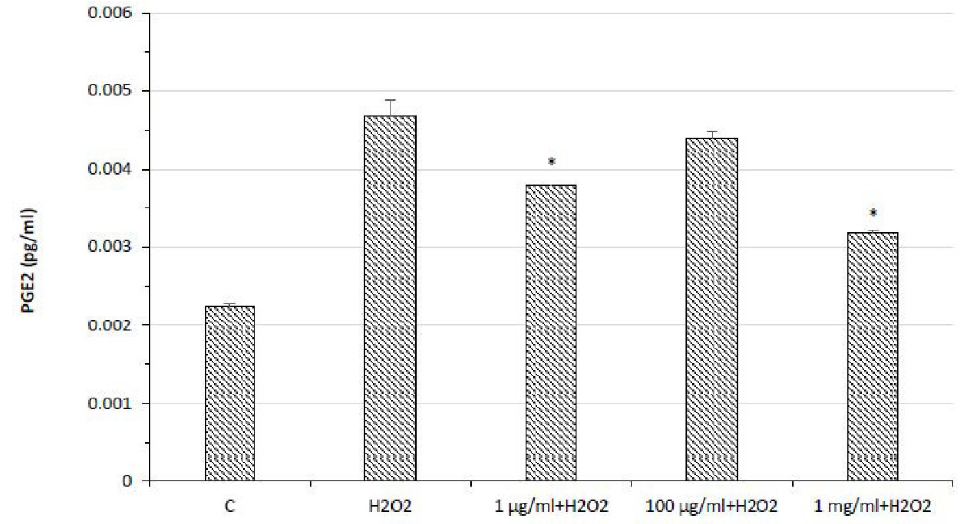
Figure 6. PGE2 production in HypoE22 hypothalamic cell line exposed to different concentrations (1–1000 µg/mL) of water pomace extract. The data graph bars are the mean ± SD ( n = 3). * p < 0.05 vs. C.